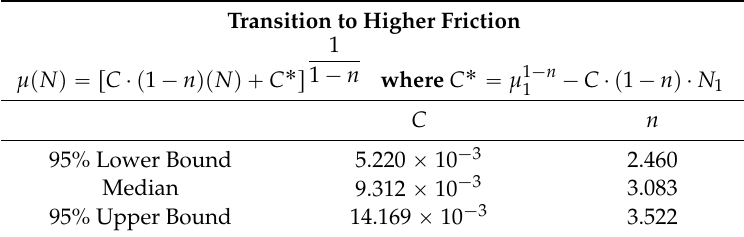
Table 2. Mathematical model and its estimated parameters for the higher friction region (Case of 25 N normal force with 1 mm displacement and 1 Hz frequency).